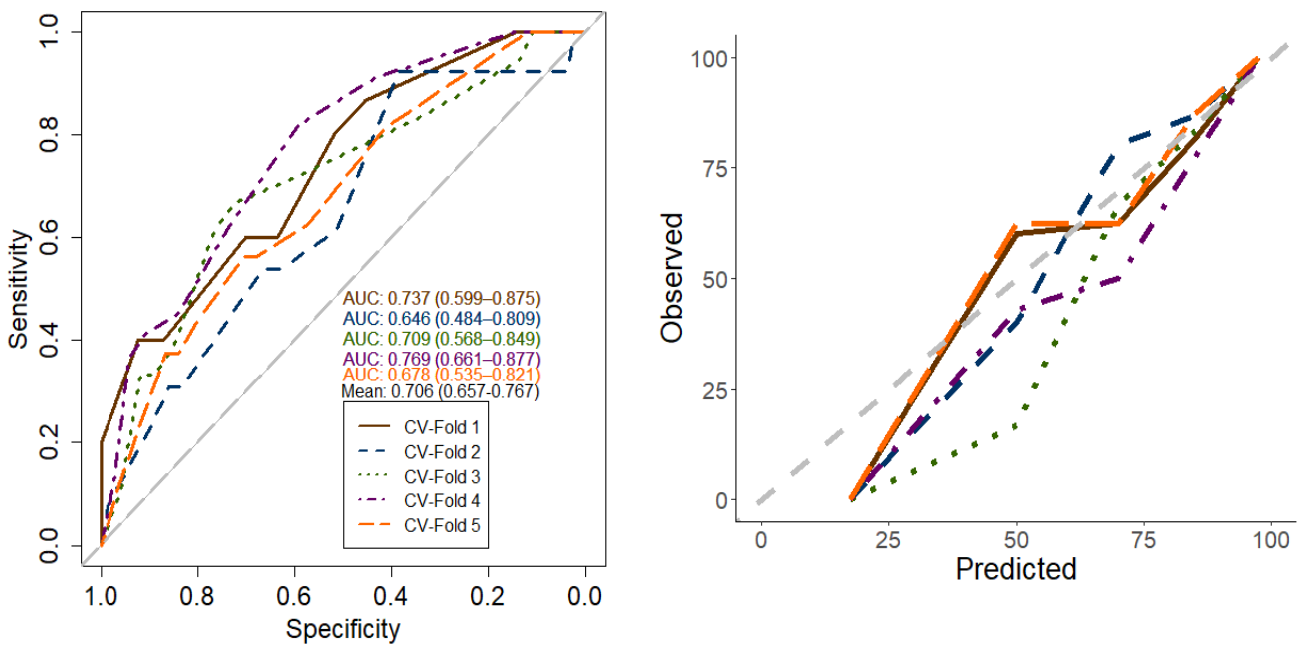
Figure 3. Decision tree performance in terms of discrimination (AUC) and calibration. Calibration plots indicate how similar the predicted probabilities are to the actual or observed values. For a perfect or ideal model, all the points should fall precisely on the dotted diagonal gray line. The plot showed good agreement between the observed and predicted probabilities for most of the cross-validation samples.